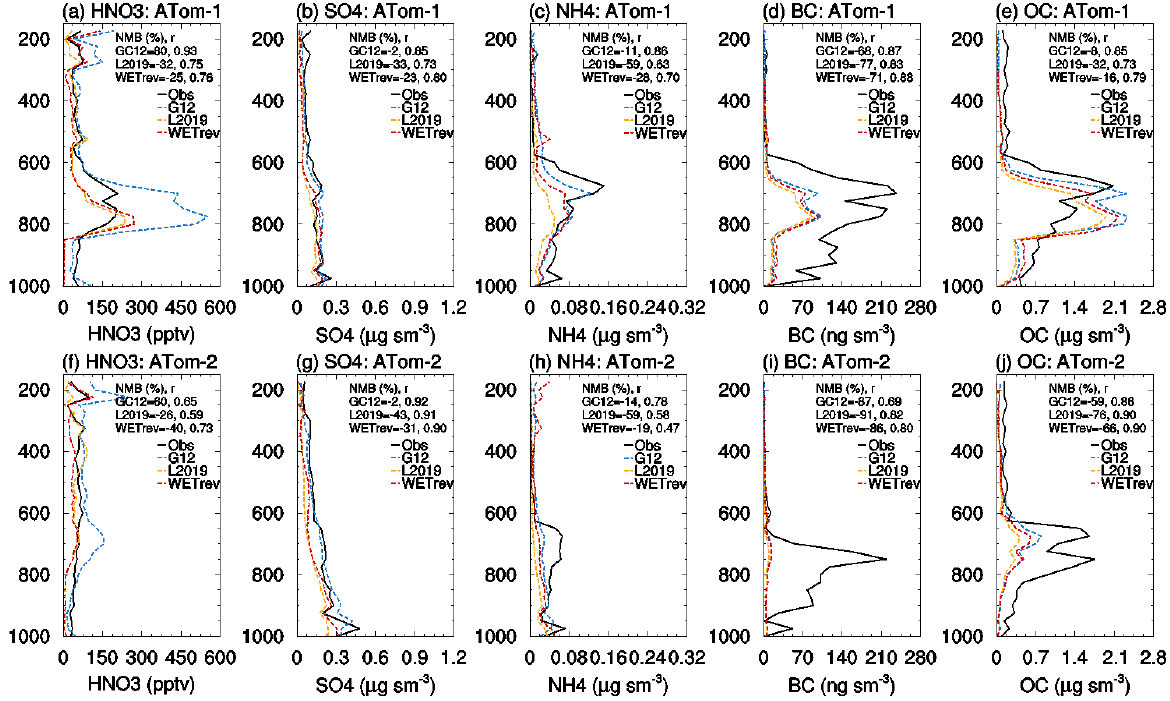
Figure 9. The same as Fig. 8 but over the Southern